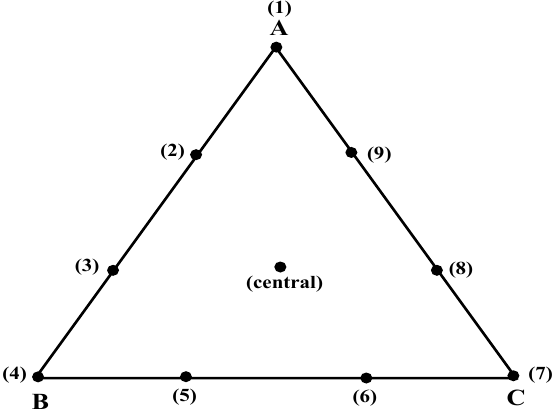
Figure 1. Extreme vertices coordinate for the mixture design. Table 1. Mix design formulations.